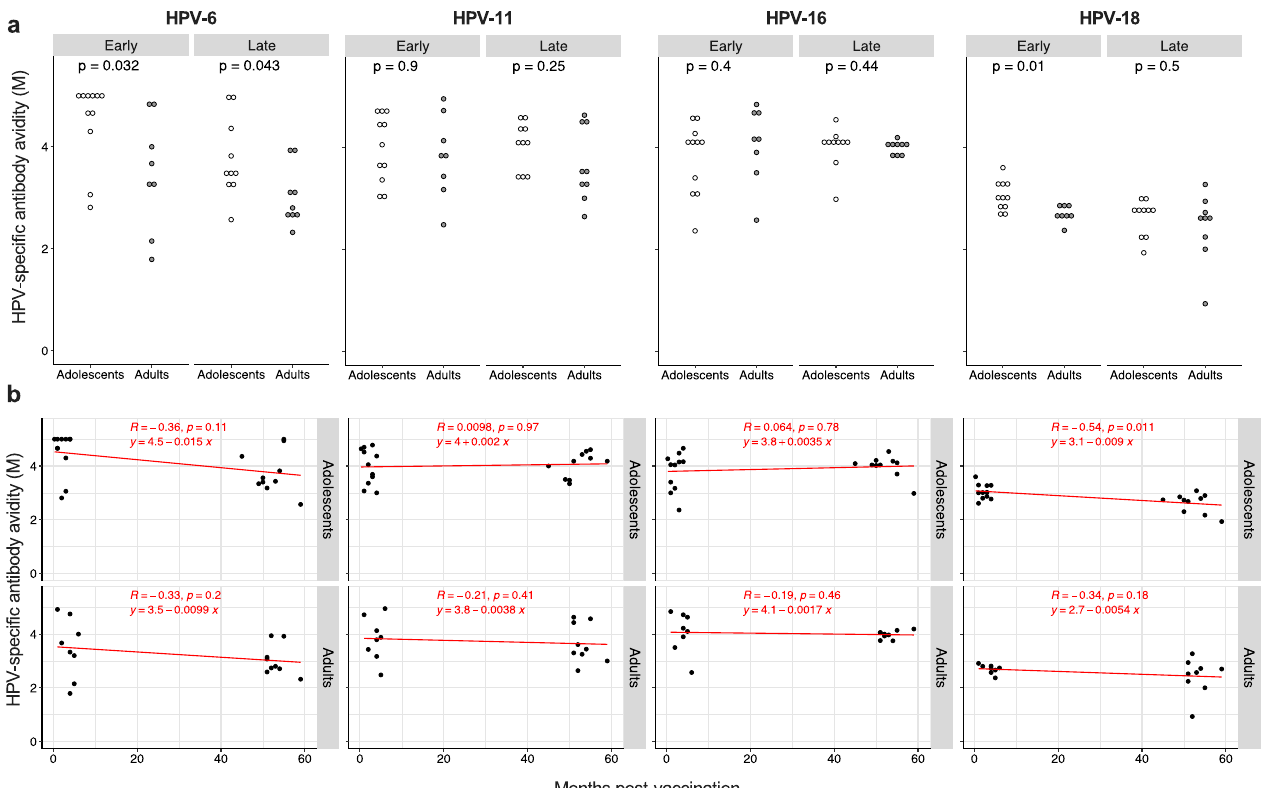
Fig. 2 Effect of age on the avidity of HPV-speci fi c antibodies. a Avidity of HPV-6, HPV-11, HPV-16, and HPV-18-speci fi c speci fi c IgG, measured in a subgroup of ELISA responders, reported as molarity (M). Each dot represents a single donor; n = 11 and n = 10 for adolescents of the “ Early cohort ” and the “ Late cohort ” , respectively; n = 8 and n = 9 for adults of the “ Early cohort ” and the “ Late cohort ” , respectively. b Molarity values (M) were correlated with with the months post-vaccination. Statistical signi fi cance was determined by the Mann – Whitney ( a ) and Spearman ’ s rank correlation ( b ) and all p -values are shown. “ Early cohort ” , Early; “ Late cohort ” ,